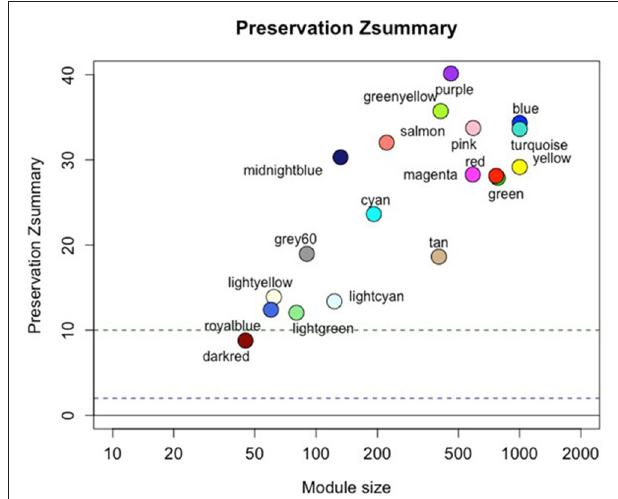
FIGURE 2 | Progressor network modules are preserved in the non-progressor network. Figure shows preservation Z summary statistic (y-axis) as a function of module size. The dashed blue (low) and green (high) lines are thresholds highlighting 2 < Z < 10 region corresponding to moderate/high preservation. Detailed statistics of all modules are listed in the Supplementary